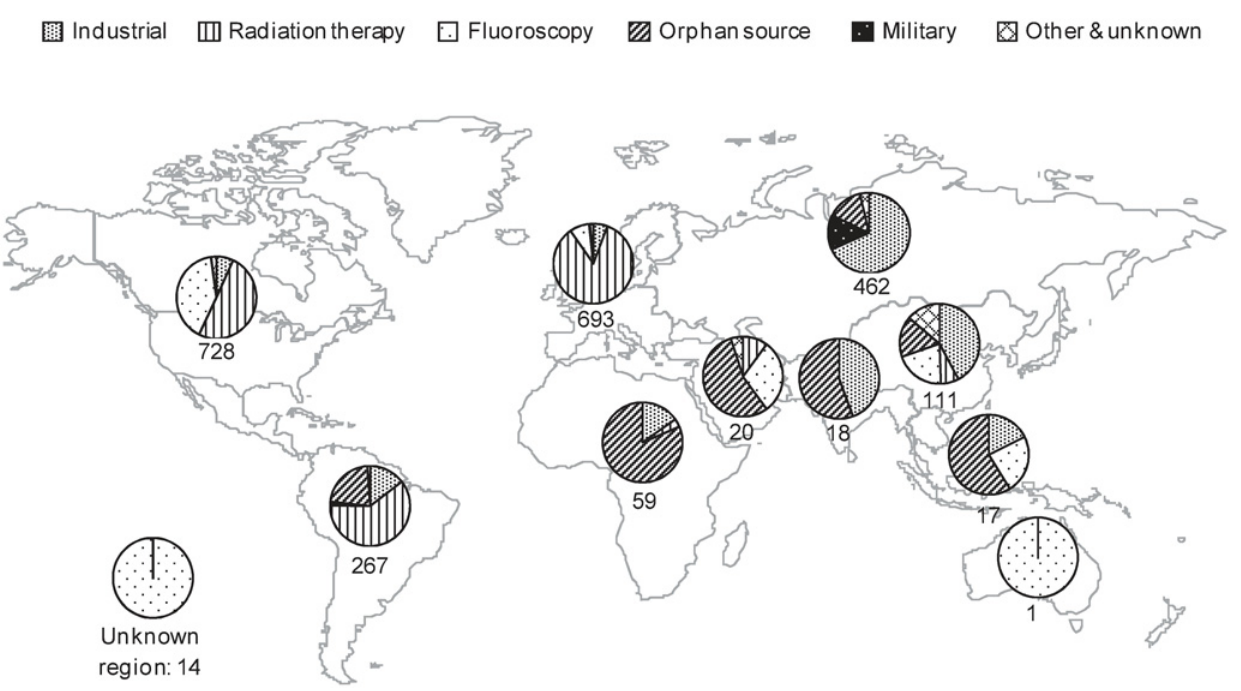
Fig 4. Distribution of sectors involved in reported overexposed people by region, 1980 –